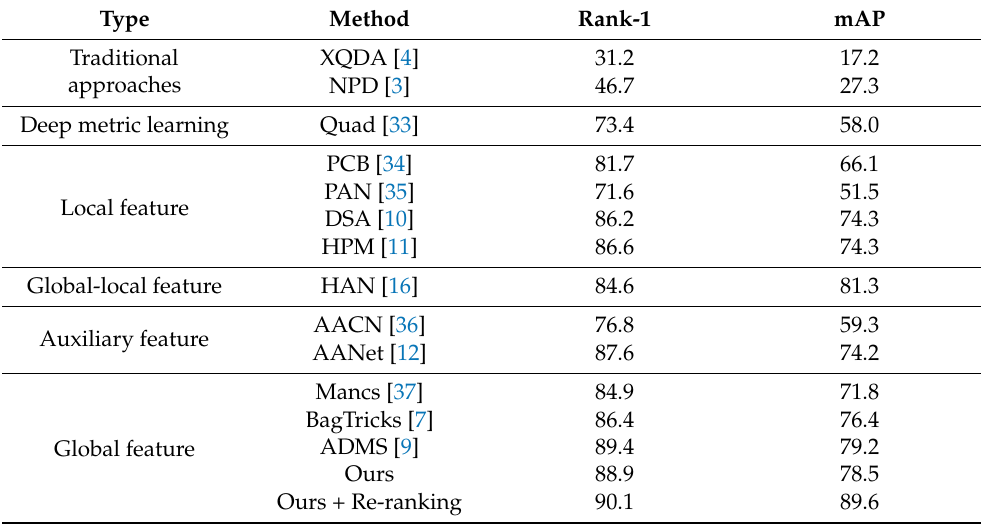
Table 5. Comparison of the results of different methods under the DukeMTMC-reID